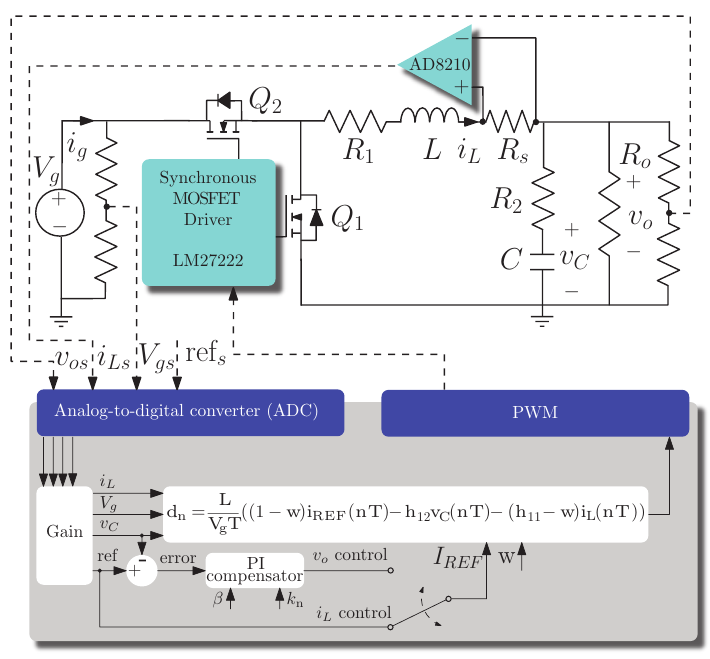
Figure 2. Schematic of the buck